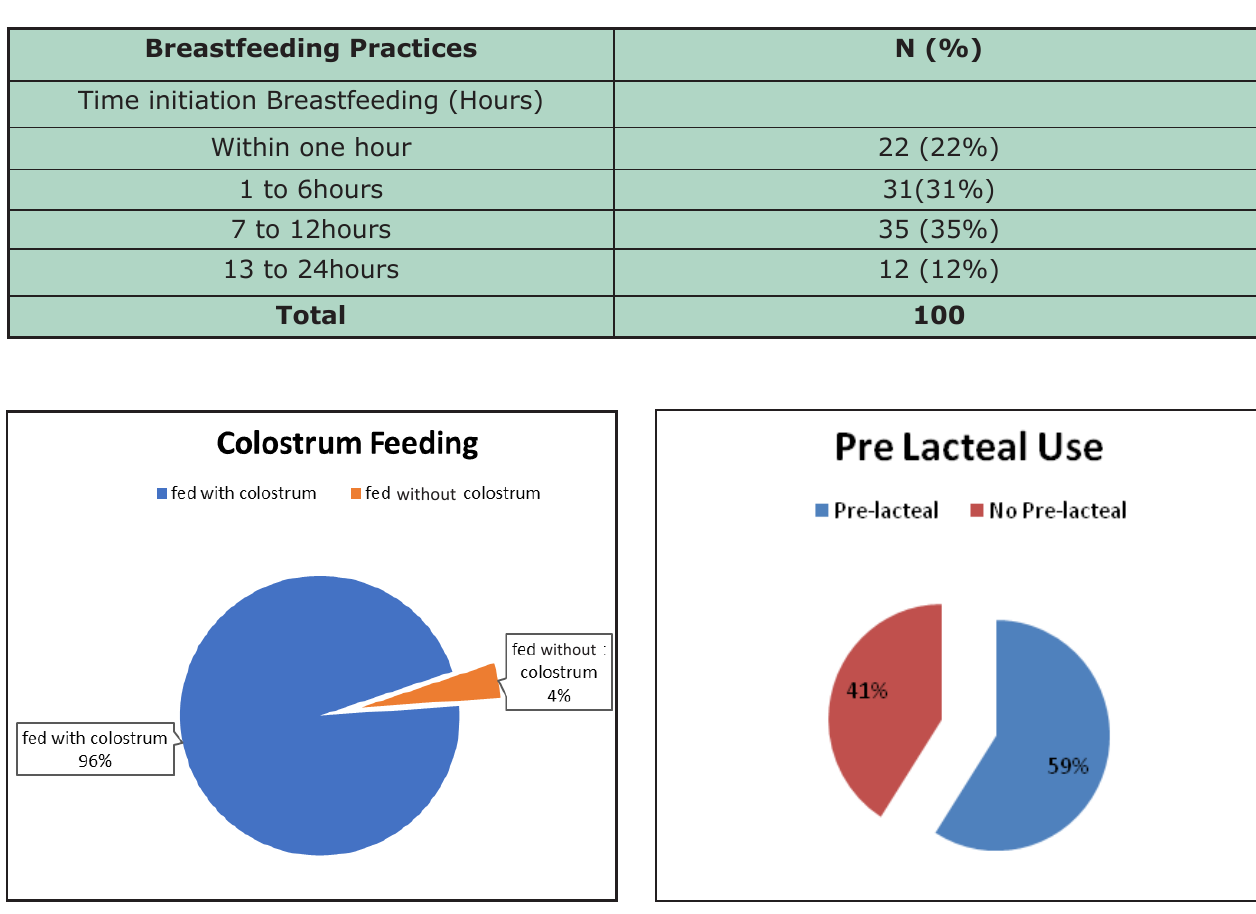
Table-I:Frequency Distribution in Relation to Breastfeeding Practices of Present Pregnancy.